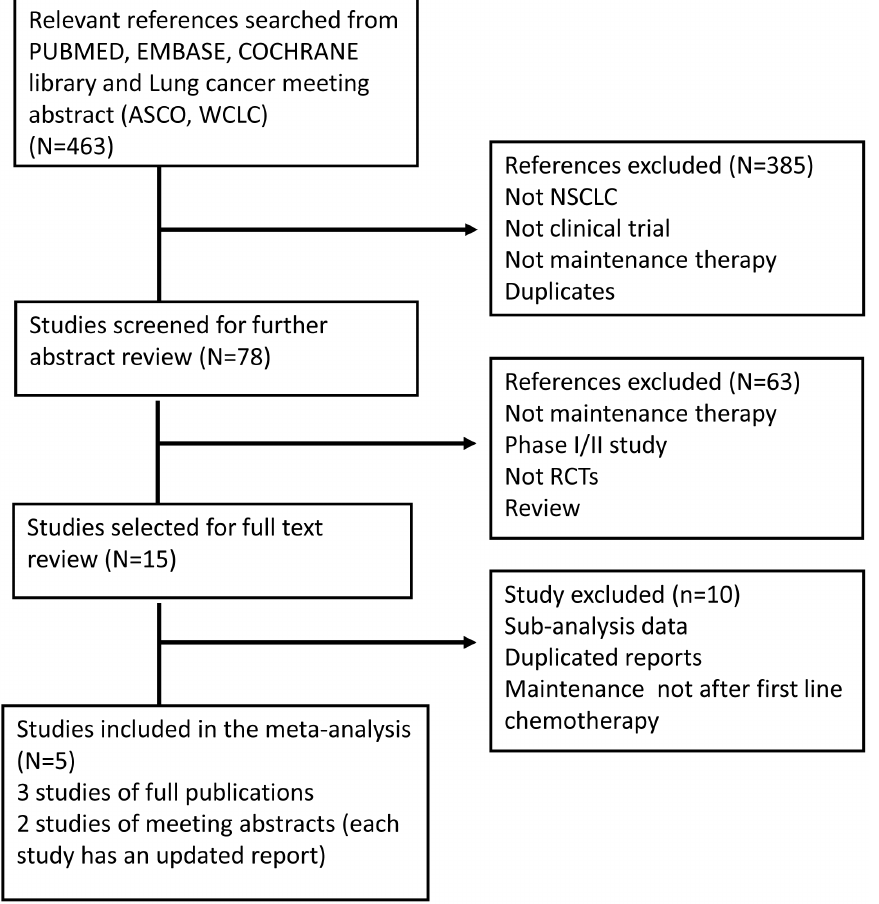
Figure 1. Flow-chart of the meta-analysis.